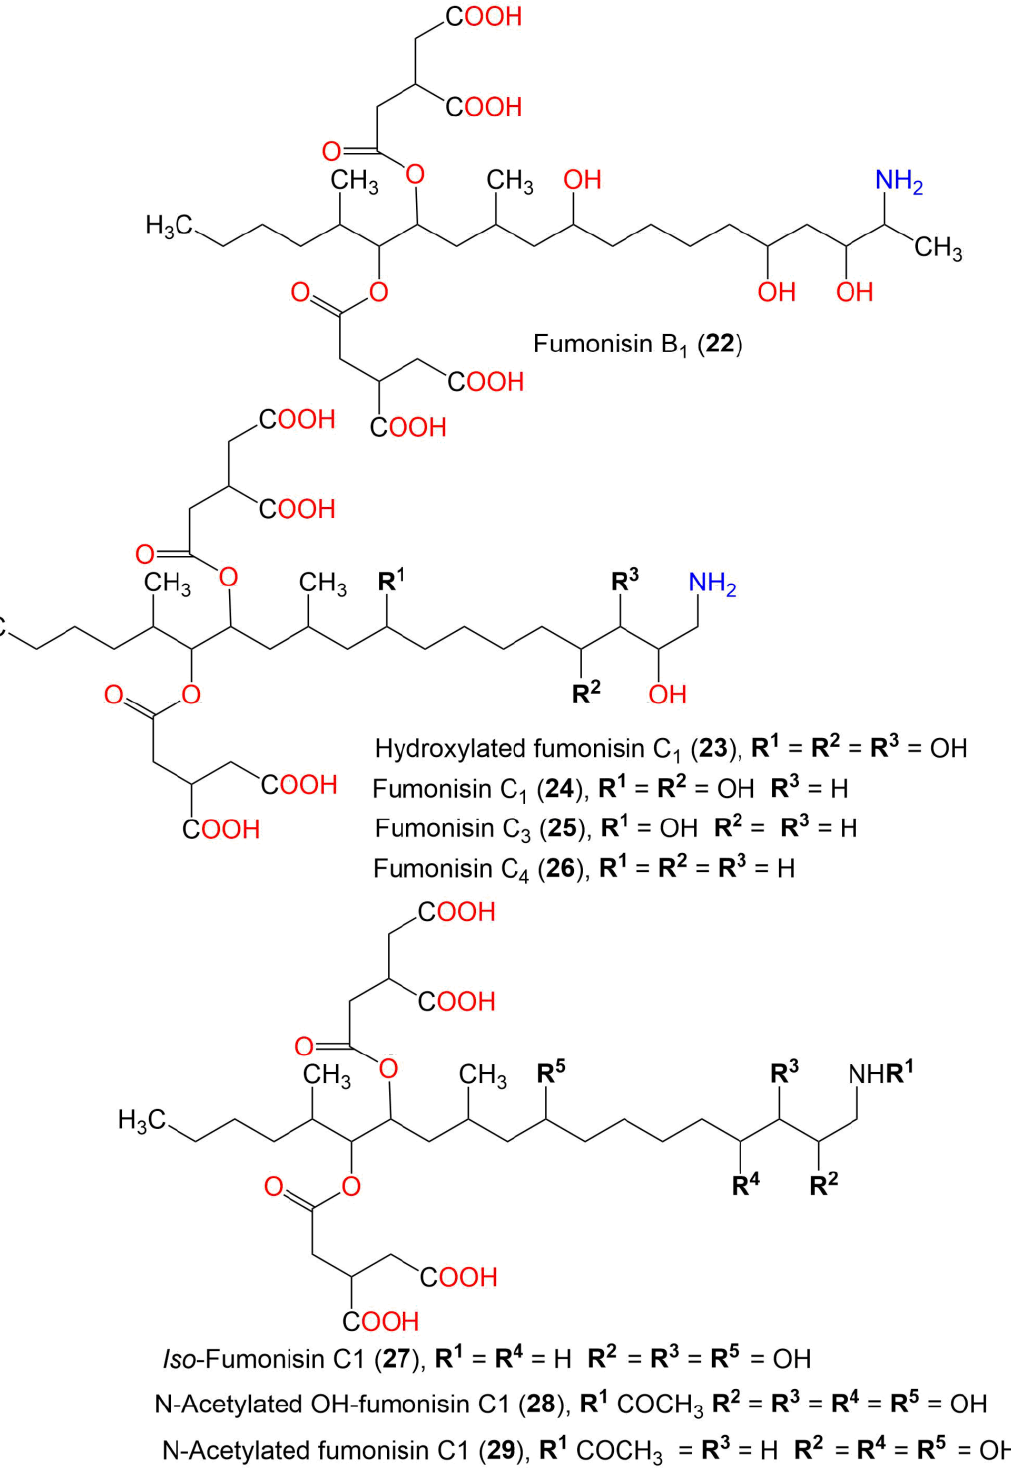
Figure 2. Structures of fumonisins 22 – 30 isolated from F. oxysporum .